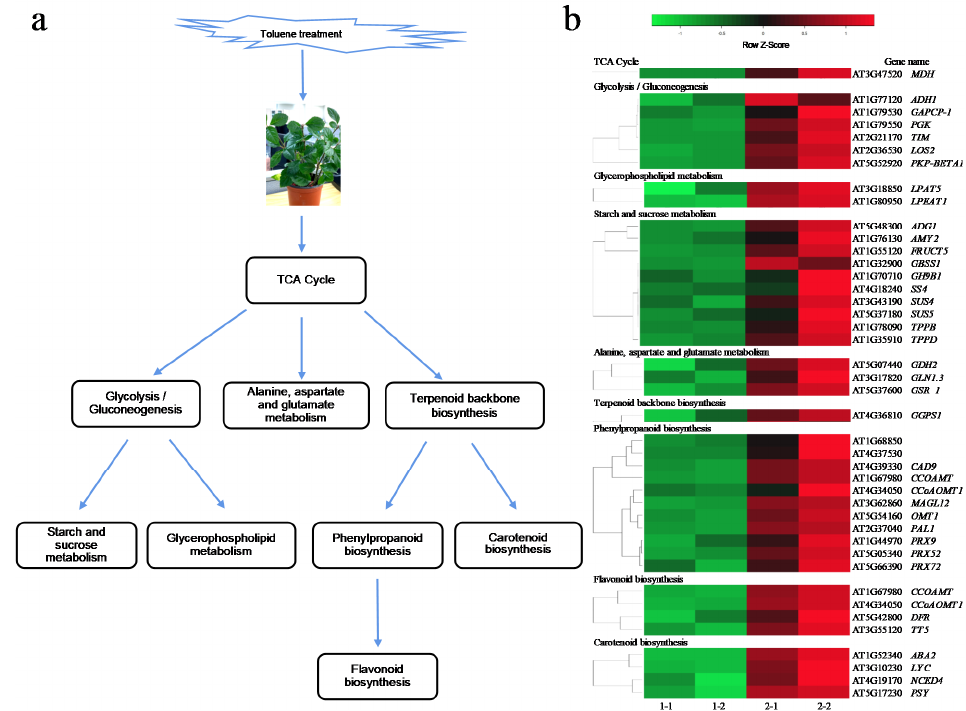
Figure 5. The models of toluene metabolic mechanism in A. pusilla . ( a ) Toluene response related to metabolic defense pathways in A. pusilla ; ( b ) heat maps of metabolic pathways DEGs in toluene untreated (1-1, 1-2) and treated (2-1, 2-2) A. pusilla . Heatmap color represents the expression level of each gene (rows) in different treatments. (fold-change ≥ 2, p -value < 0.05). Red bars: upregulation; green bars: downregulation.